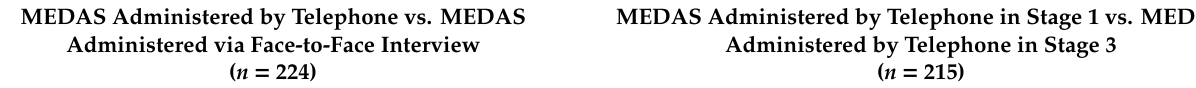
Table 5. Agreement between MEDAS performed in the three di ff erent stages (MEDAS administered by telephone vs. MEDAS administered via face-to-face interview and MEDAS administered by telephone in Stage 1 vs. MEDAS administered by telephone in Stage